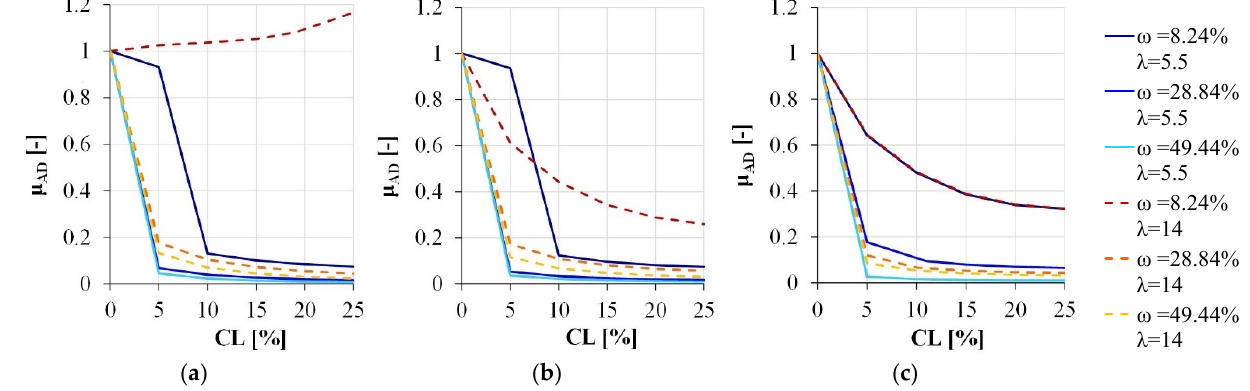
Figure 7. Local ductility variation due to the corrosion degradation: ( a ) ν = 25.65%, ( b ) ν = 15.39%, ( c ) ν = 5.13%.